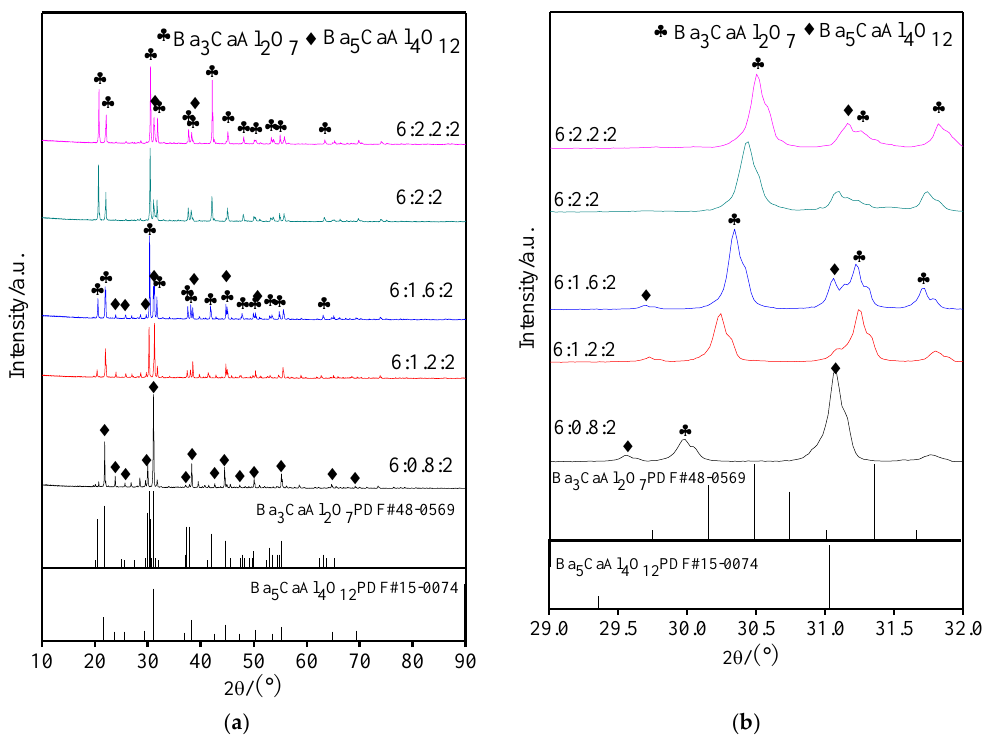
Figure 3. XRD patterns of molten 6BaO·xCaO·2Al 2 O 3 aluminates; ( a ) XRD patterns in 10~90°; and, ( b ) Partial enlarged drawing in 29~32° of ( a ).